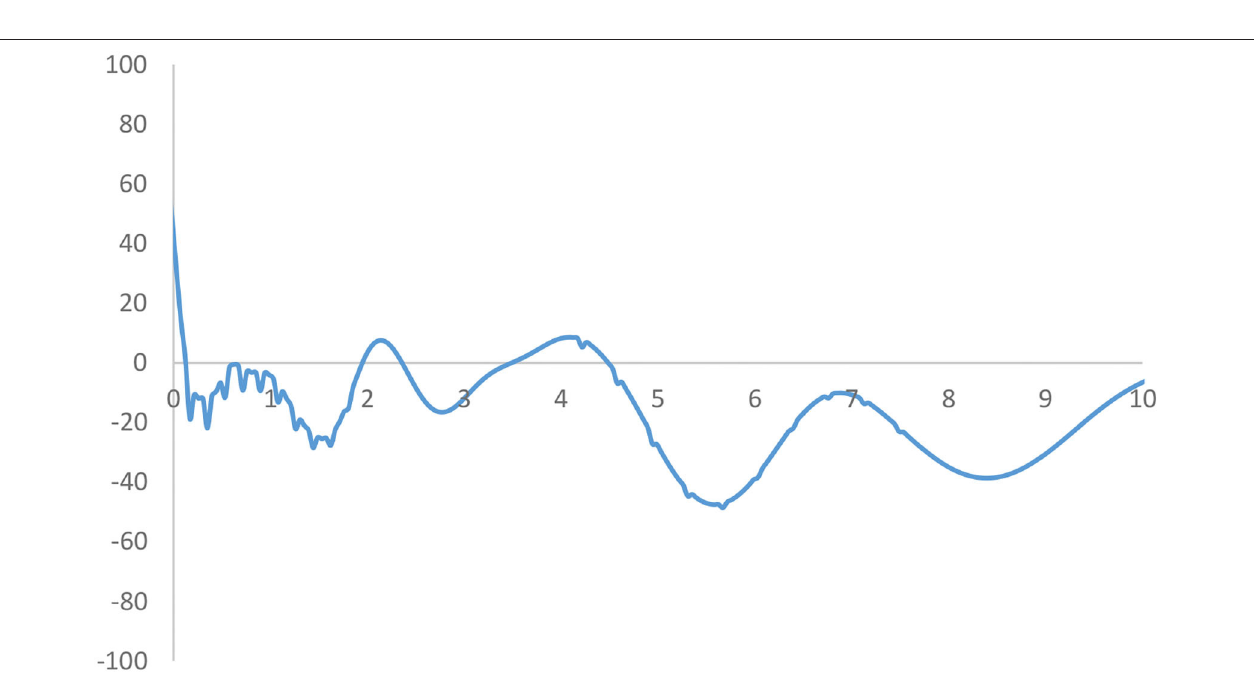
FIGURE 4 | Mobility probability plot (MPP) for the RIVAPC of all countries. Source: authors’ calculation. N.B. The vertical axis indicates net upward mobility (%) and the horizontal axis indicates RIVAPC values.